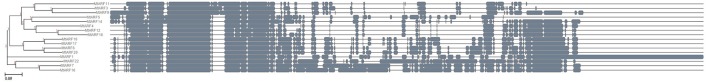
Dendrogram constructed following multiple sequence alignment for the 16 MtARFs represented by at least one probe in the MtGEA using Clustal Omega and ETE 3 visualization framework.